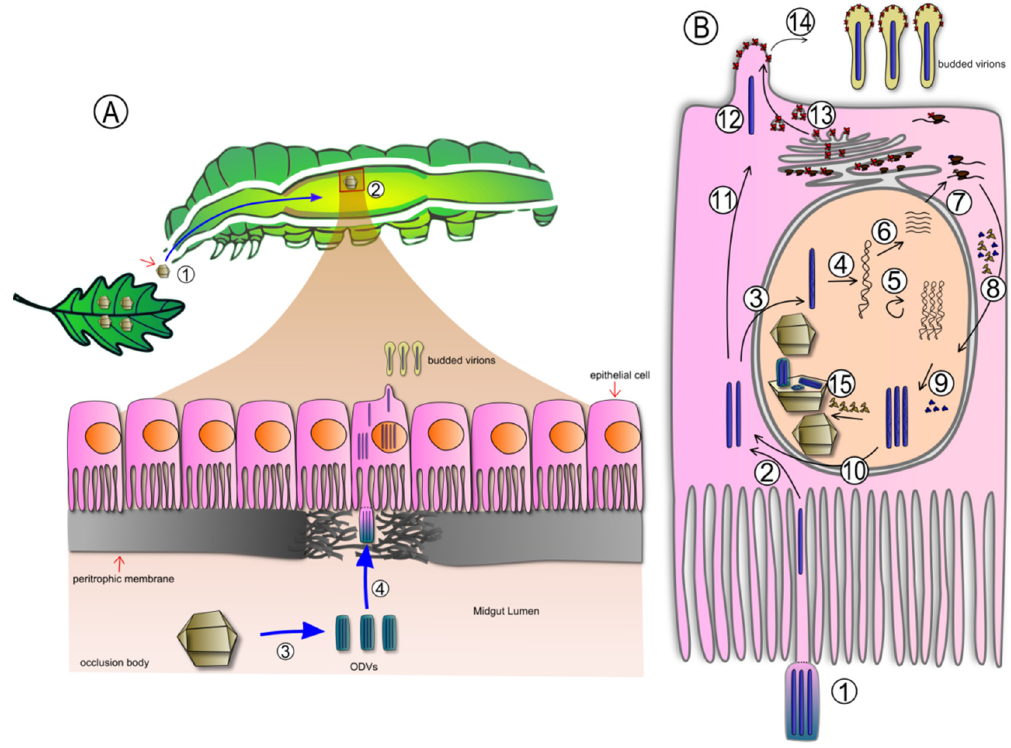
Figure 2. Baculovirus infectious cycle. ( A ) Cross sectional schematic of an insect larva. A baculovirus occlusion body (OB) ingested with contaminated food starts a new infectious cycle (1). When OBs pass through the foregut and reach the alkaline midgut the proteinaceous matrix is dissolved (2), releasing ODV (3). The peritrophic membrane is degraded by virus and host encoded enzymes present in the OB (4), allowing the ODV to enter the cell; ( B ) Representation of the virus replication cycle. ODV enters the cell by fusion with epithelial cell microvilli (1), releasing nucleocapsids (NC) into the cytoplasm (2). NC may enter the nucleus (3), disassemble and release the genome (4). Then early genes are transcribed (6) and translated (7). Some of the proteins translocate into the nucleus (8), take part in genome transcription/replication, NC and virion assembly (9). In the first stages of viral infection, NC is transported to the cytoplasm (10), approaches the basolateral cell membrane (CM) (11) and emerges as budded virus (BV) (12) in the spots where the viral envelope fusion protein (EFP) (14) accumulates using the secretory pathway (13). In the very late stages of infection, NC are enveloped in the nucleus and occluded in the polyhedral shaped protein matrix (OB) (15) (adapted from [27], copyright 2013, The Authors). Once released, ODV face the barrier of the peritrophic membrane (PM), a lattice of chitin, mucopolysaccharides and proteins that separates food from midgut tissue [28]. The PM lattice has pore sizes ranging from 21 to 36 nm in diameter [29], so that small particles, such as degradative enzymes, can pass freely through the lattice as part of the digestive process, but the passage of larger